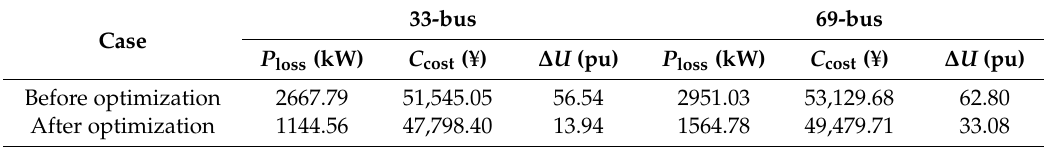
Table 4. Comparison of optimization results of the two distribution